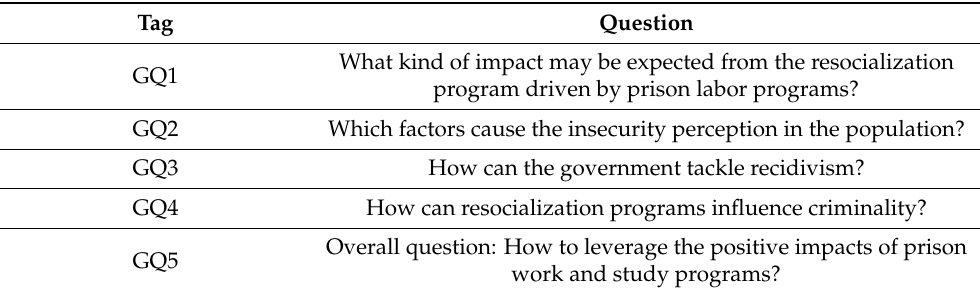
Table 2. Guiding